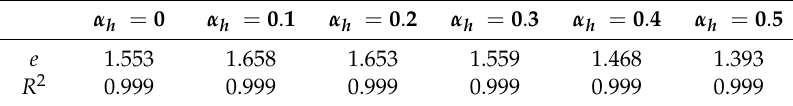
Table 5. Fitting parameters of Type D cell analyses.